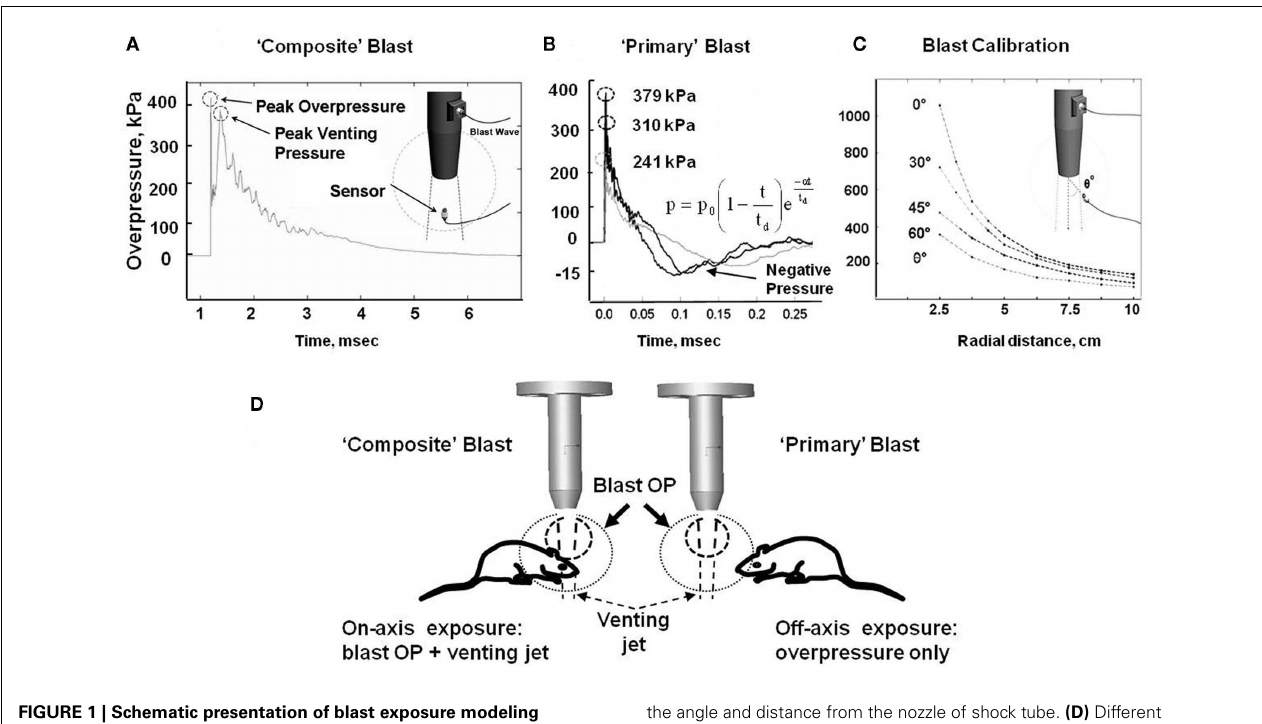
FIGURE 1 | Schematic presentation of blast exposure modeling in rats. (A) Overpressure recording on shock tube axis at 5cm from the nozzle. (B) Overpressure recording with external “pencil” PCB at 5cm and 45˚ from shock tube nozzle at three different diaphragm configurations. (C) Calibration of pressure on rat head depending on